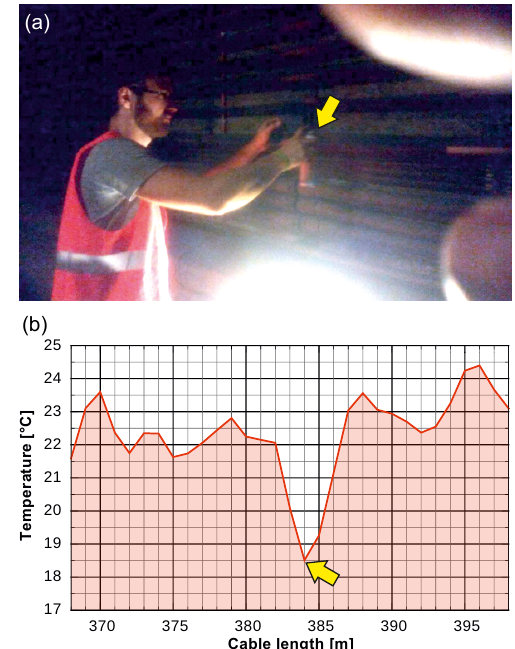
Figure 3. Localization of exact positions ( ± 0.5m) by using freez- ing spray (a) and the response of recorded temperatures of the fiber- optic cable using a measurement configuration with a spatial sample rate of 1m (b) .